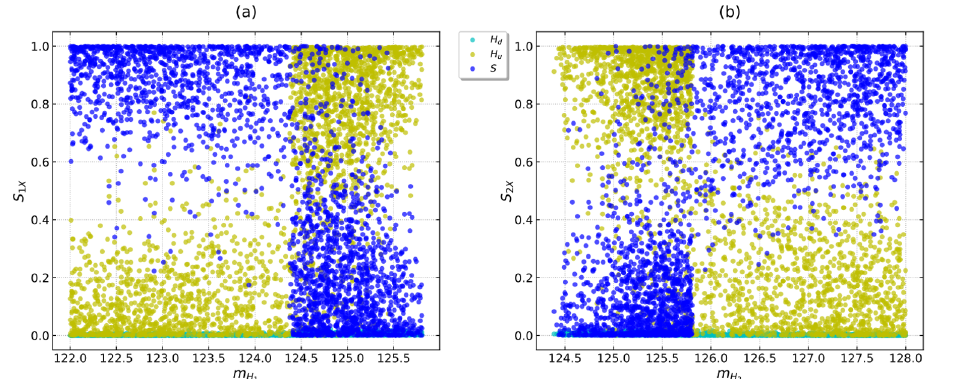
Figure 14 . All surviving samples in figure 5 are projected on plots m H versus µ , m versus µ . The red samples represent µ H 1 m H V BF H 2 V BF 1 samples represent µ H 2 = σ H 2 , and the gold samples represent µ H 1 /σ SM V BF V BF V BF